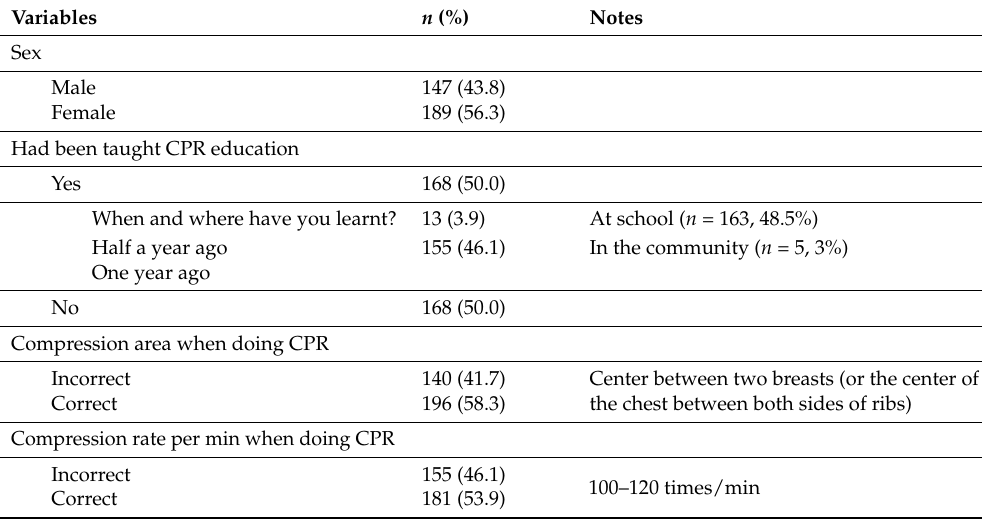
Table 1. Demographic characteristics ( n =